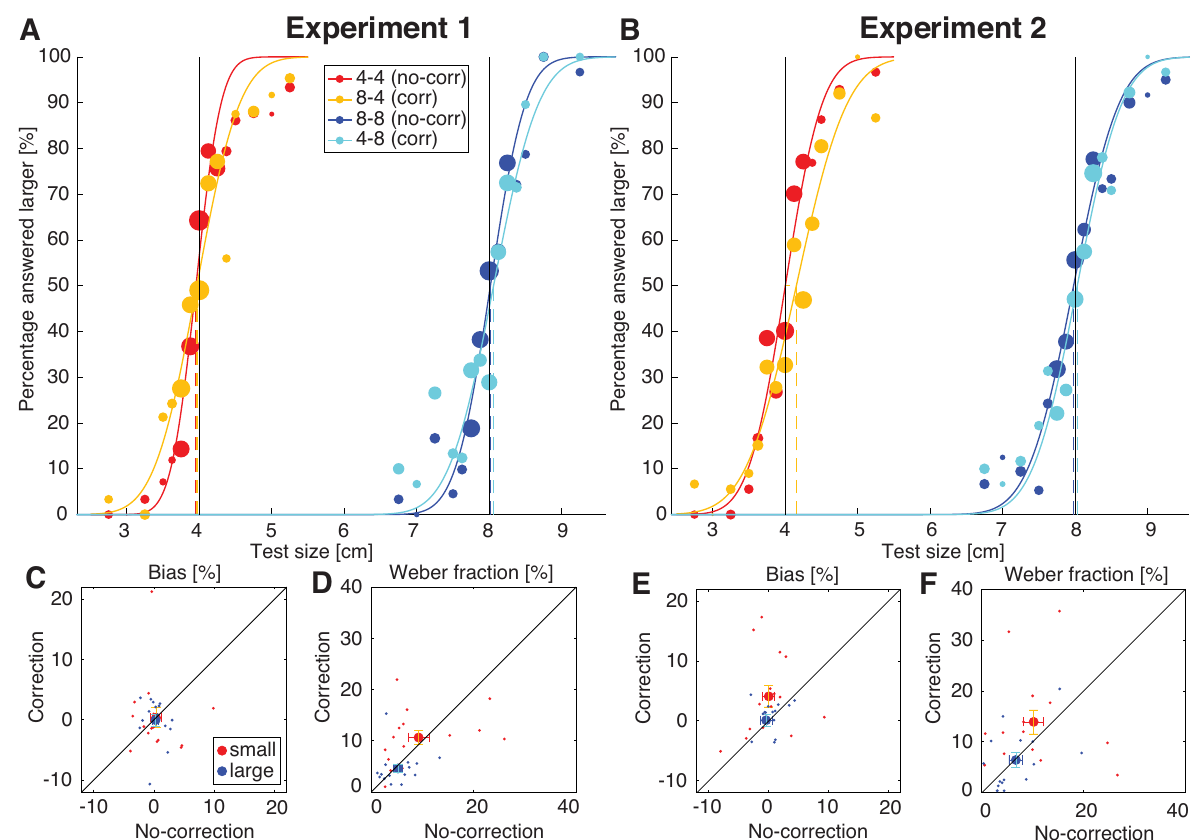
Fig 5. Perceptual biases and Weber fractions. A-B: Average psychometrical curves in Experiment 1 (A) and 2 (B). Solid lines indicate reference values and dashed lines indicate biases. Dot size represents the number of trials. Colours indicate different conditions: no-correction small (4–4), correction small (8–4), no-correction large (8–8), correction large (4–8). C-F: Biases (C,E) and Weber fractions (D,F) as obtained from the fitted curves for both experiments. Values from the correction conditions are plotted against those from the no-correction conditions, for a small and large reference separately. Error bars represent standard error, dots indicate individual participant values. The diagonal black line represents the points where the correction condition is equal to the no-correction condition. It can be seen that most values are scattered around the diagonal, indicating no differences between correction and no-correction conditions, except for the bias for small objects in Experiment 2. Weber fractions are on average larger for small compared to large objects in both